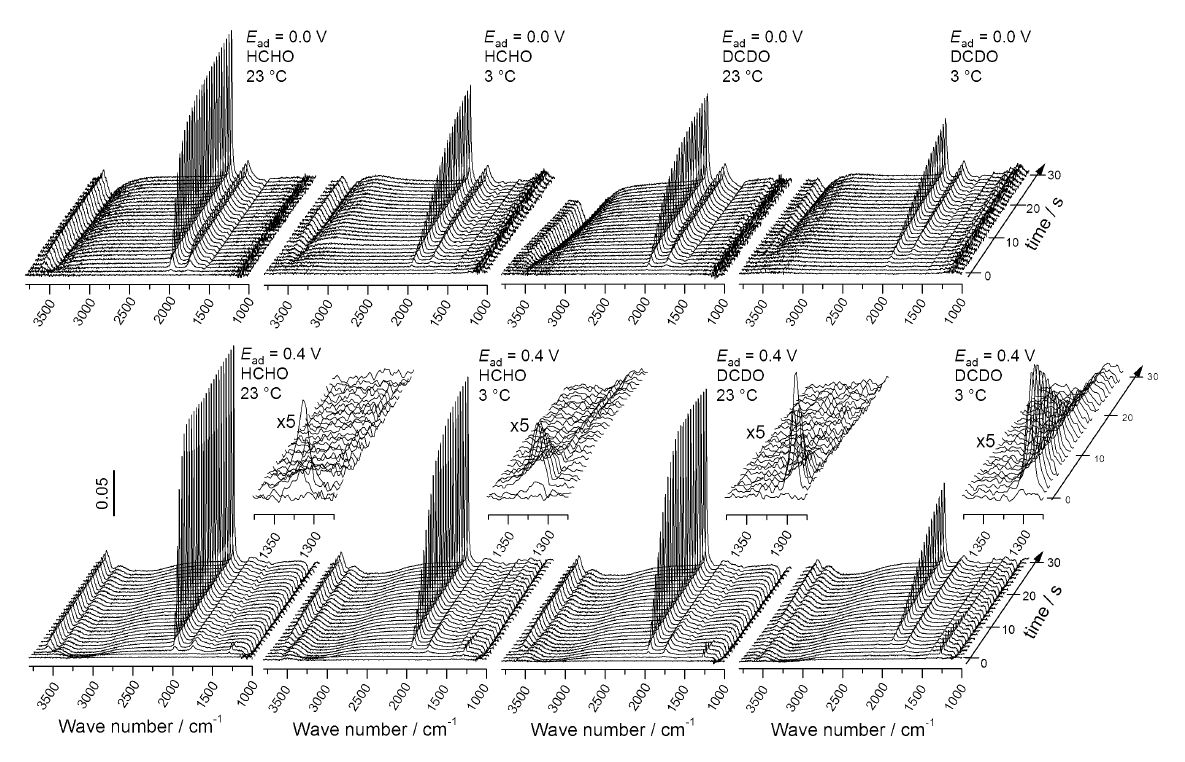
Figure 1: Temporal evolution of the ATR-FTIR spectra upon admission of 0.1 M H2- or D2-formaldehyde solution in 0.5 M HClO 4 at 0.0 V (upper panel) or 0.4 V (lower panel) to a Pt film electrode at different temperatures (for notations see figure). Insets: five-fold magnified temporal evolution of adsorbed formate